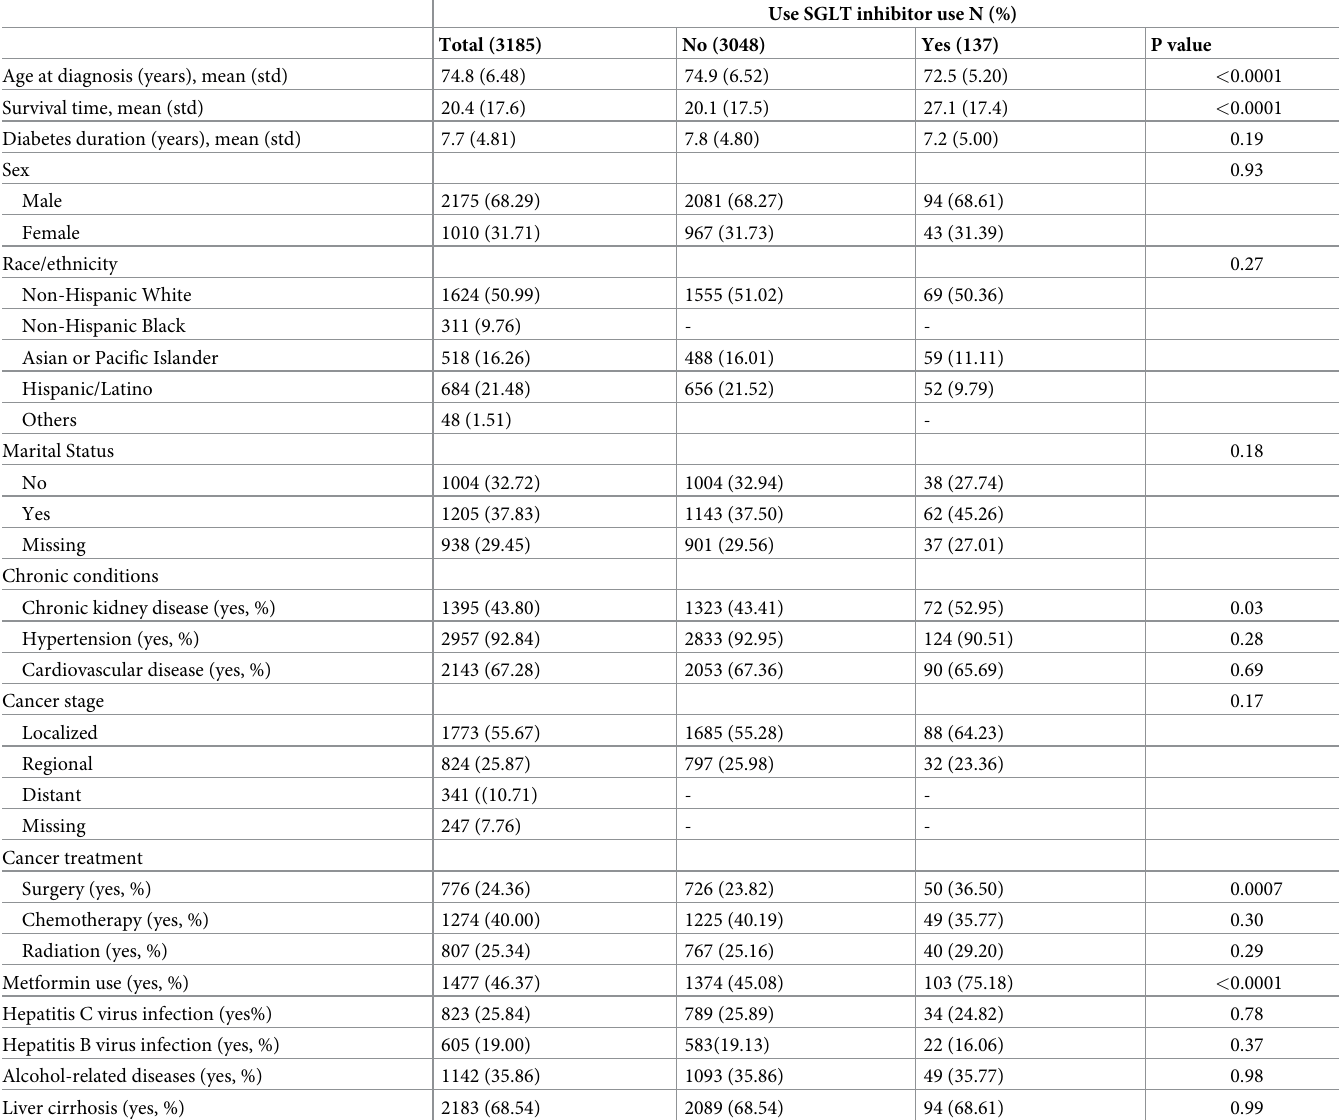
Table 1. Patients’ characteristics by sodium-glucose cotransporter 2 (SGLT2) inhibitor use status among 3,185 hepatocellular carcinoma patients � .